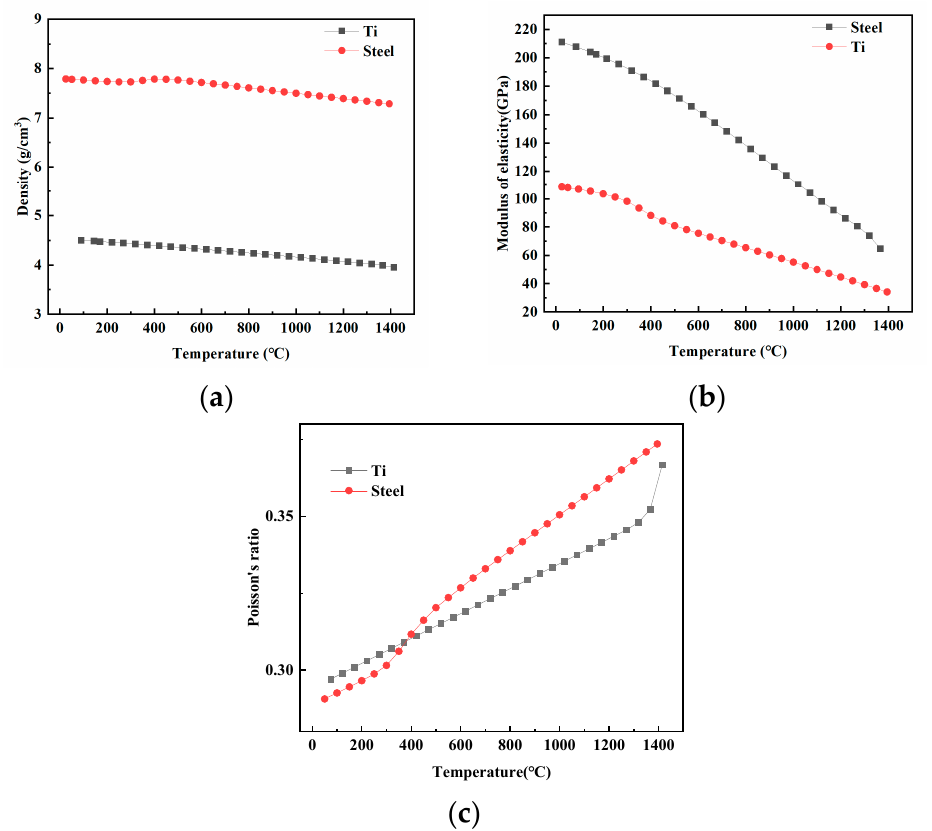
Figure 2. Parameters of the materials Ti and Steel. ( a ) Density, ( b ) modulus of elasticity, ( c ) Poisson’s